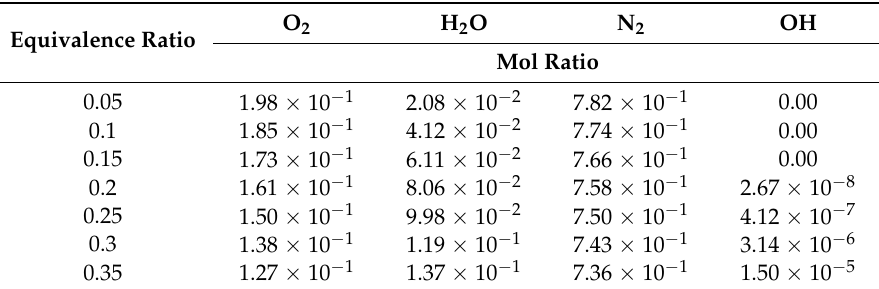
Table 2. Co-flow components’